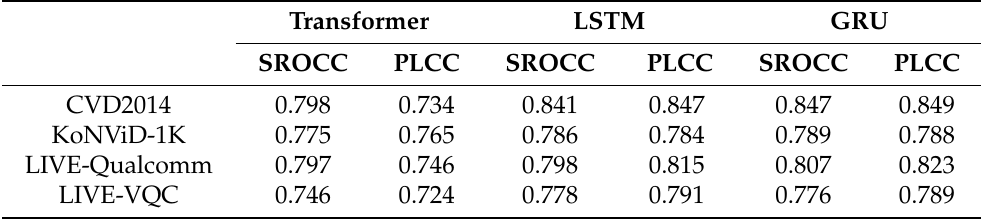
Table 8. Comparison of different long-term dependency models.